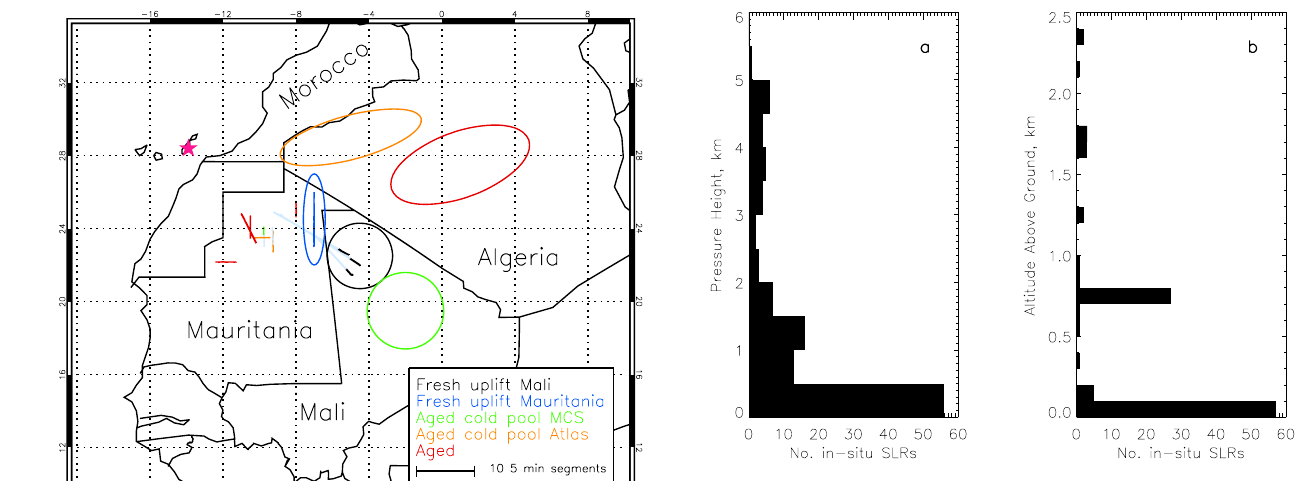
Fig. 2. (a) Histogram of altitudes (in pressure height) of in-situ horizontal legs; (b) histogram of altitude above ground of horizon- tal legs from the aircraft radar, where data is available at altitudes lower than 2.4km above the ground surface (subsample of pressure heights beneath 2.4km from (a)